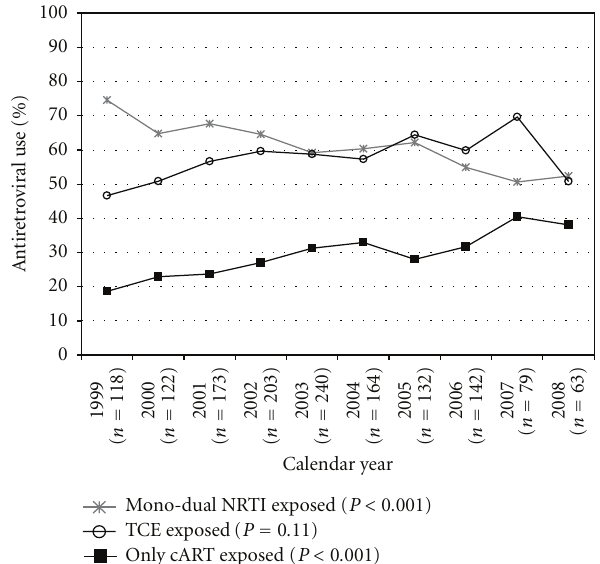
Figure 3: Frequency of ART experience categories, among viremic (HIV viral load > 1,000 copies/mL) patients who underwent geno- typic testing in the HIV Outpatient Study, 1999–2008.